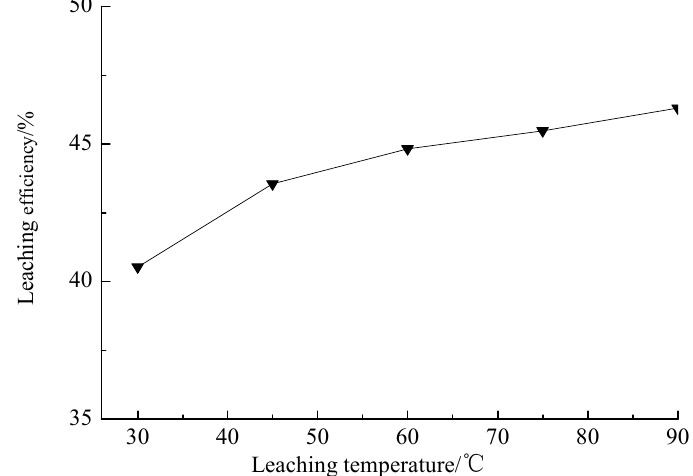
Figure 6. Effect of leaching temperature on zinc extraction.